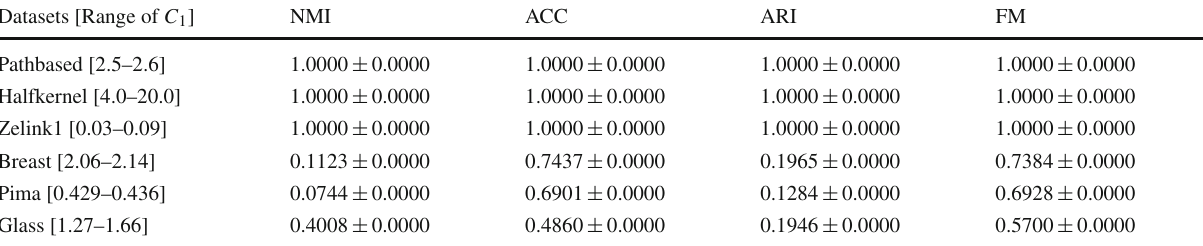
Table 13 Sensitivity analysis of AmDPC algorithm to parameter C 2 Datasets [Range of C 2 ] NMI Pathbased